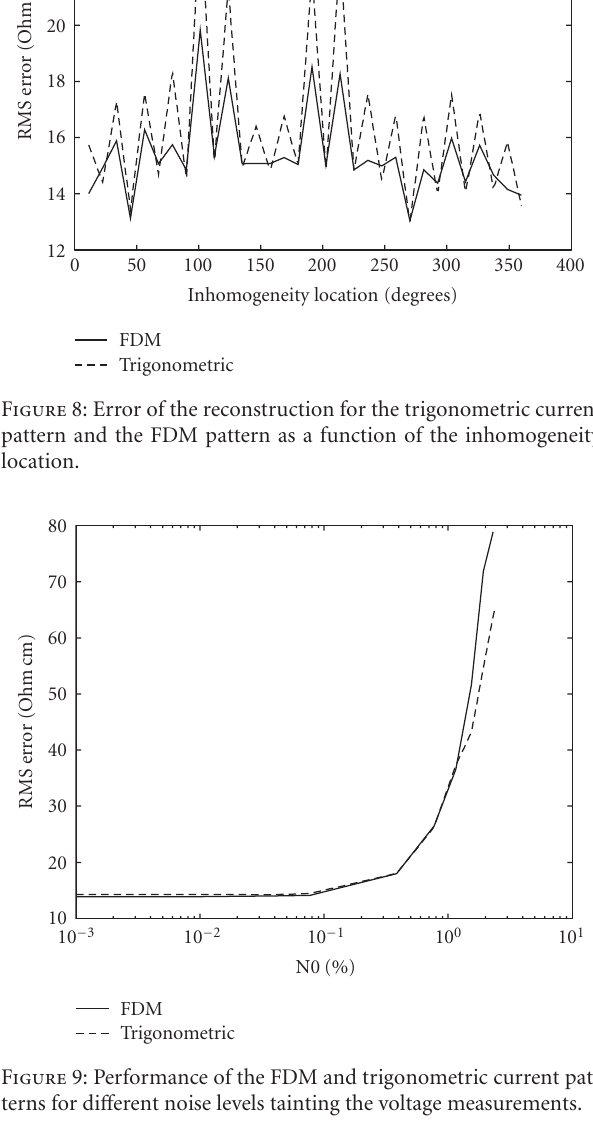
tested the FDM current pattern with additive white gaussian noise tainting the voltage measurements and compared the performance to that of the trigonometric current pattern.